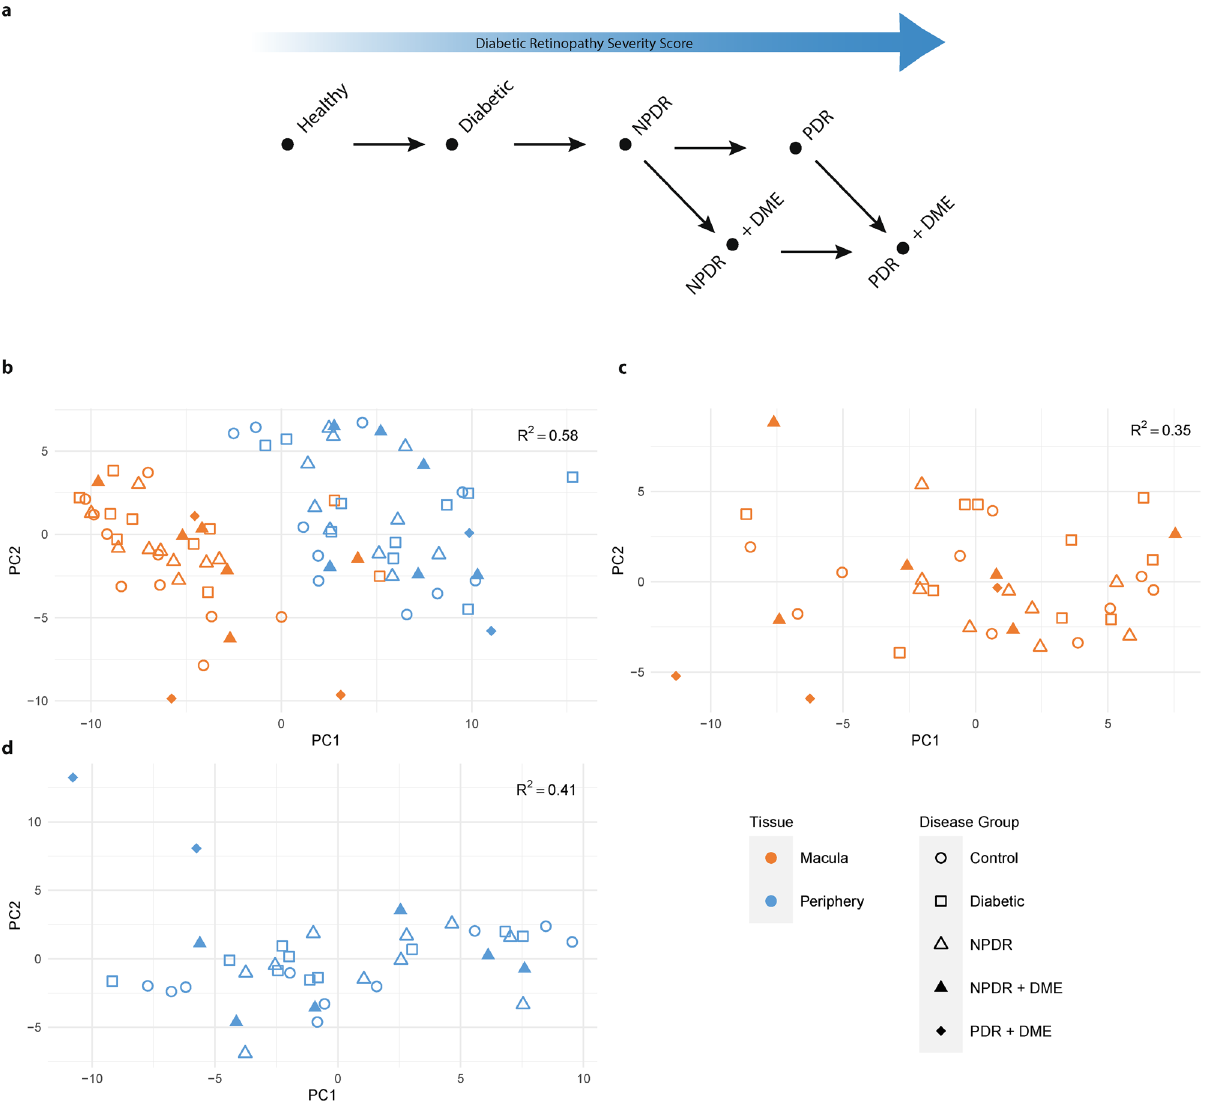
Figure 1. Gene expression differences between sample sites: ( a ) Schematic of disease progression in DR (NPDR: Non-Proliferative Diabetic Retinopathy, PDR: Proliferative Diabetic Retinopathy, DME: Diabetic Macular Edema). From left to right the Diabetic Retinopathy Severity Score (DRSS) increases. ( b ) Principal component analysis (PCA) scores of combined and processed mRNA and miRNA expression values for all samples. ( c ) PCA scores of macula samples only. ( d ) PCA scores of periphery samples only. In all cases, PCA was applied to the top 100 most variable features in each sample group (all, macula, periphery). Cumulative R 2 - values for two principal components are shown in the upper right